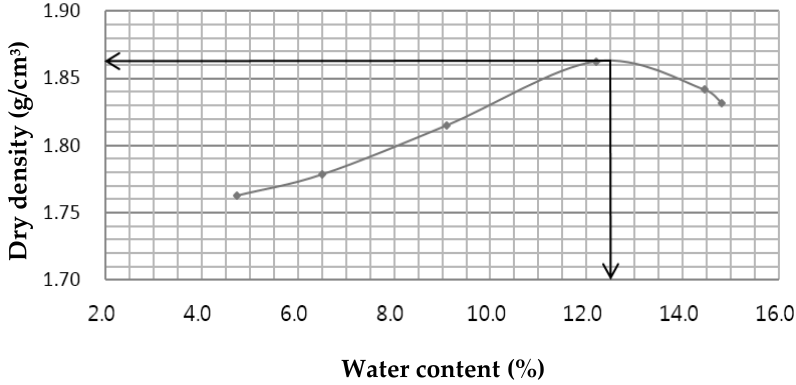
Figure 1. Compaction curve of soil to be tested.